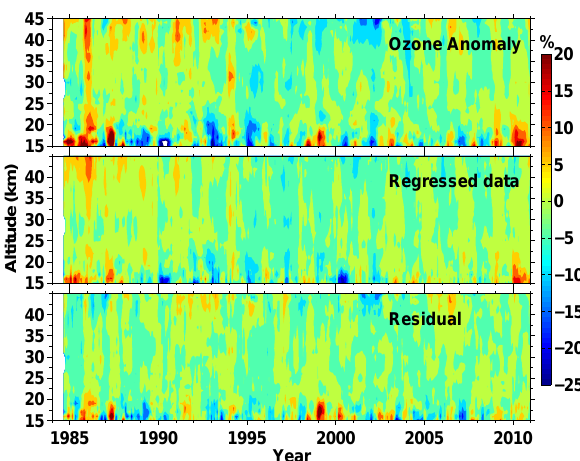
Fig. 6. Temporal evolution of the vertical distribution of average ozone anomaly (top panel), regression model (middle panel) and residual (bottom panel) at OHP over the period